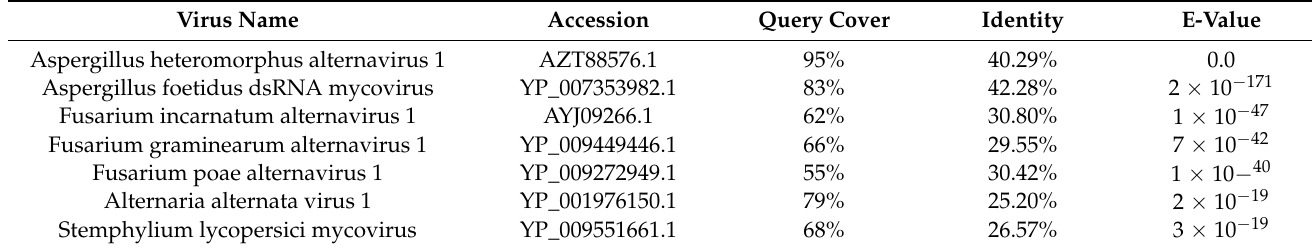
Table 2. Identity between FoAV1 ORF2-encoded protein and equivalent proteins of other proposed alternaviruses.